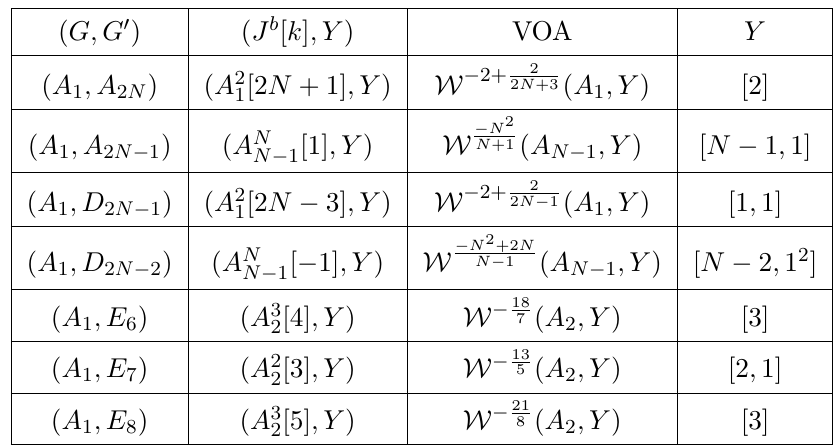
Table 6 . The VOA of ( A 1 ; ADE ) theories. Here Y = [ n 1 ; n 2 ; : : : ; n s ] means that the nilpotent orbit has the Jordan block with size n 1 ; : : : ; n s